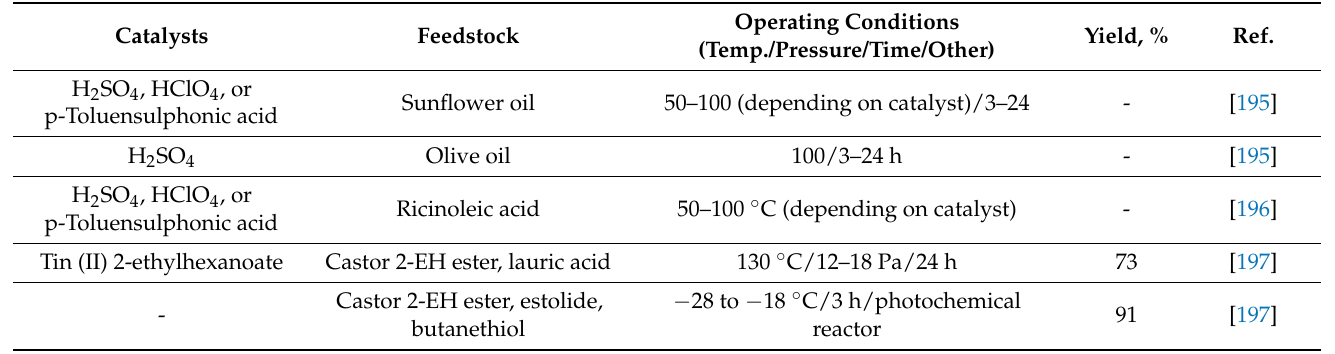
Table 9. The overview of catalysts used for